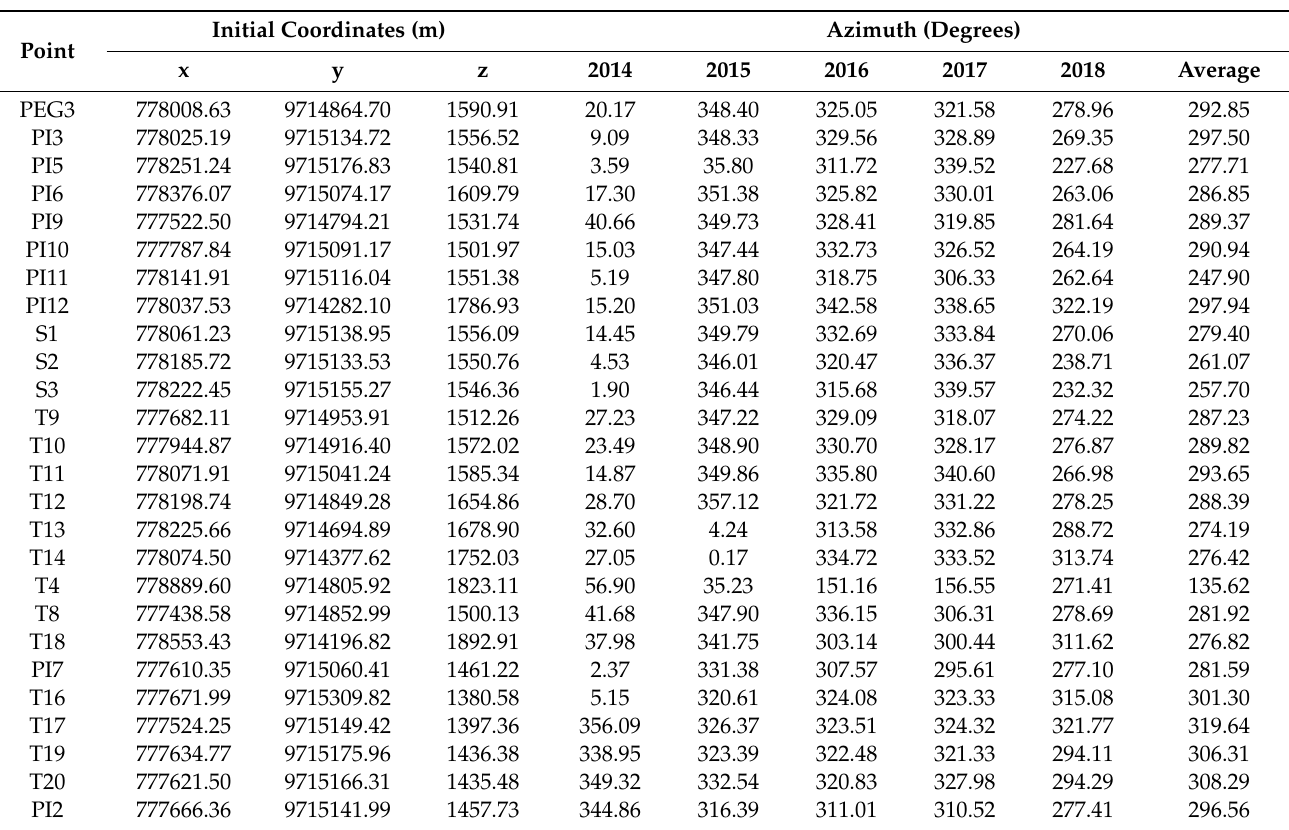
Table A4. The initial coordinates and azimuth of movement detected by 26 fixed points in Guarumales from 2014 to 2018.